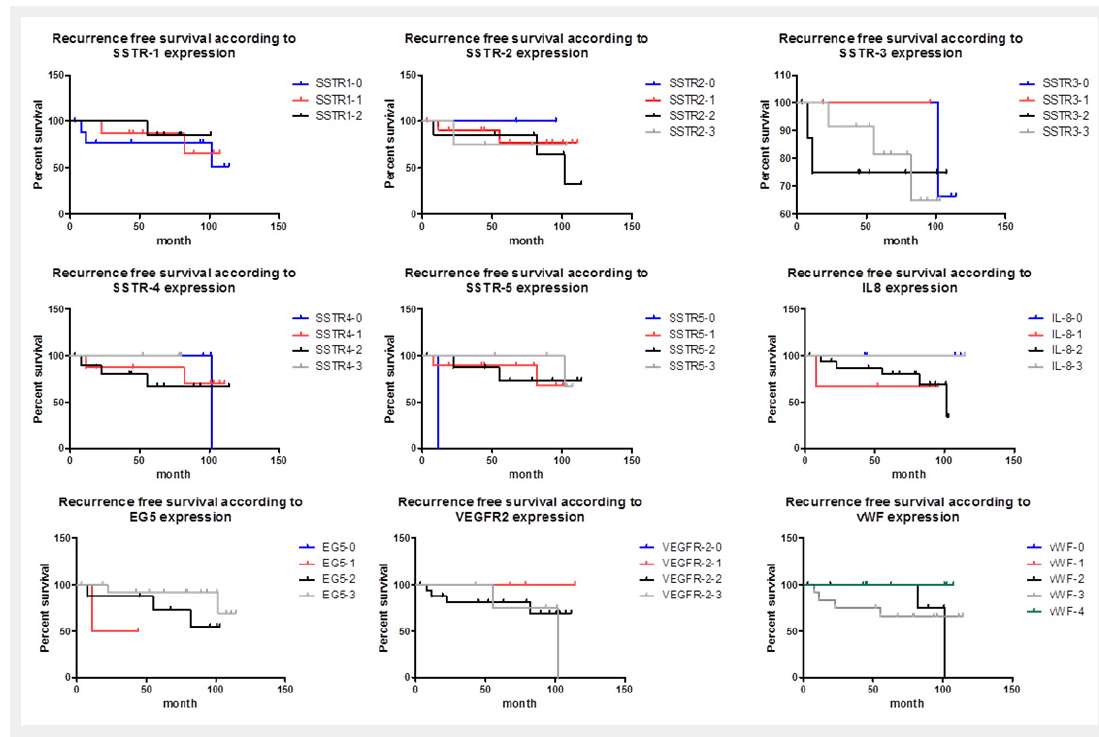
Figure 5 Kaplan-Meier curve showing the different markers and recurrence-free survival. Eg5 = kinesin spindle protein; IL-8 = interleukin-8; SSTR = somatostatin receptor; VEGFR-2 = vascular endothelial growth factor receptor-2; vWF = von